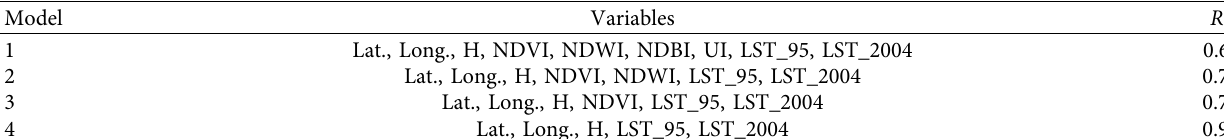
Table 7: MARS models evaluation for different